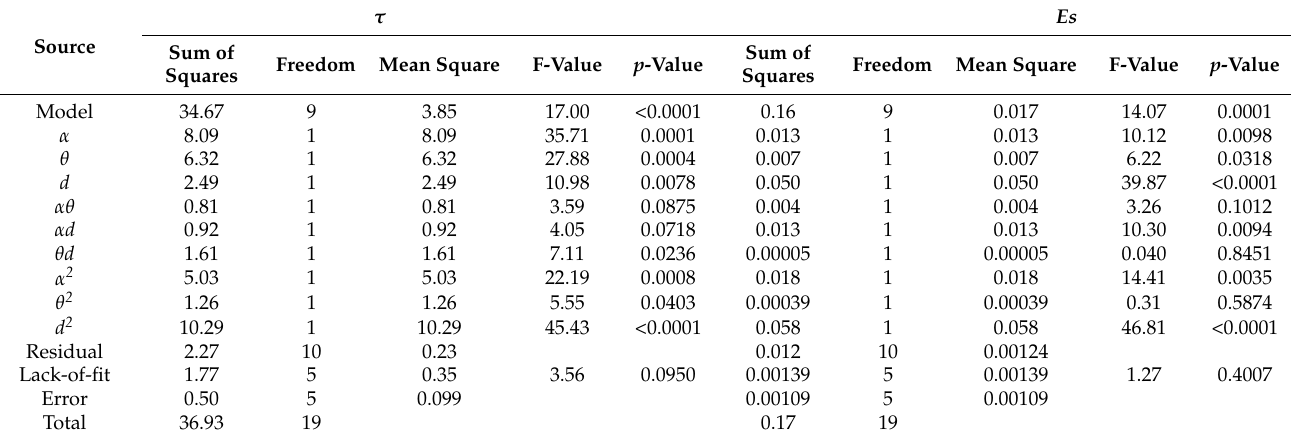
Table 4. Variance analysis results of the RSM